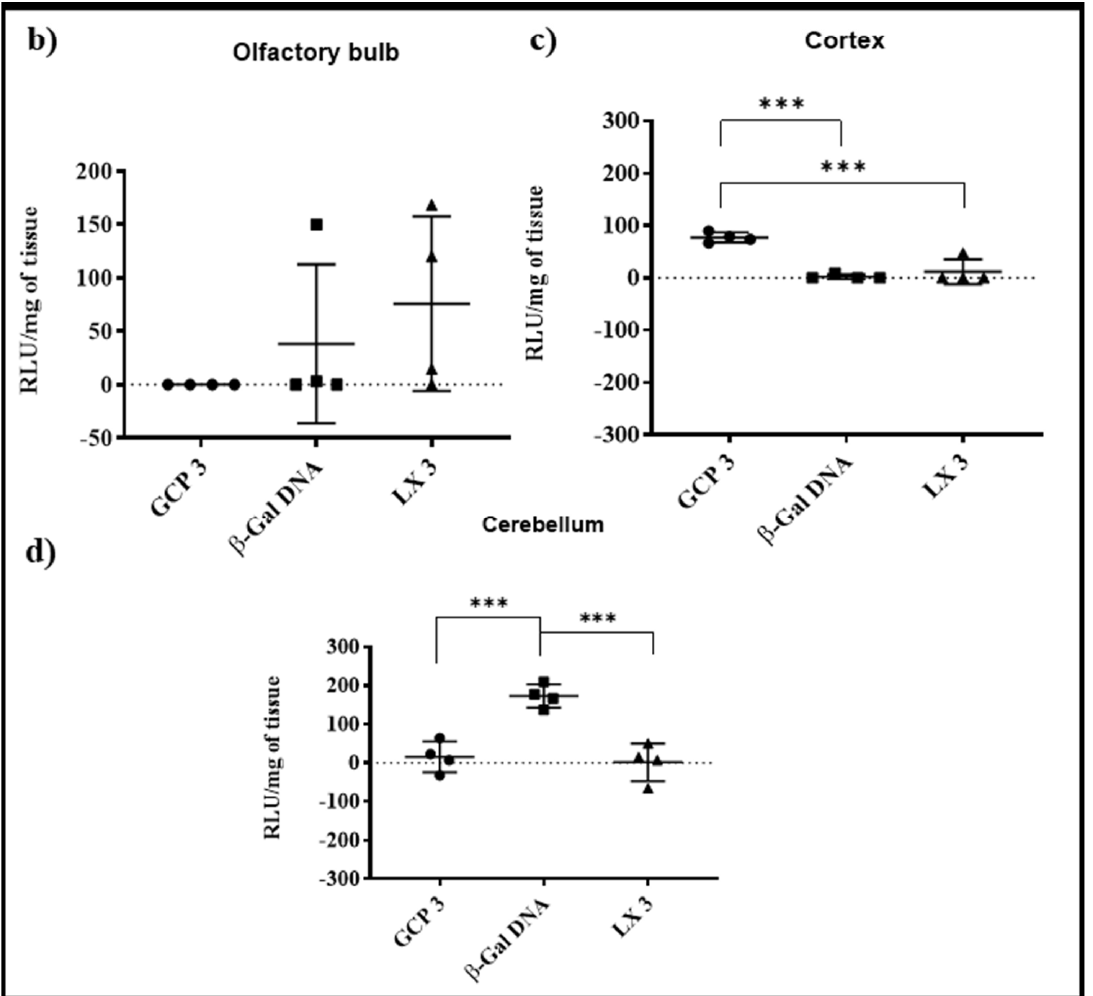
Figure 4. Representative IVIS images from an in vivo intranasal study with nanocomplexes prepared with 84 µ g mL − 1 DNA or a dose of 0.067 mg kg − 1 DNA ( a ). Imaging was taken 24 h post intranasal administration of the treatments and 1 h after intranasal administration of the substrate and with a 240 s exposure time. Downstream analysis of brain homogenates (mean ± s.d., n = 4) for active β -Gal expression 24 h post nanocomplex administration at a dose of 250 µ g mL − 1 DNA or a dose of 0.2 mg kg − 1 DNA in olfactory bulbs ( b ), cortex (GCP 3 polyplexes show significantly higher levels of active β -Gal enzyme when compared to naked β -Gal DNA and LX 3 (*** p ≤ 0.001), ( c ) and